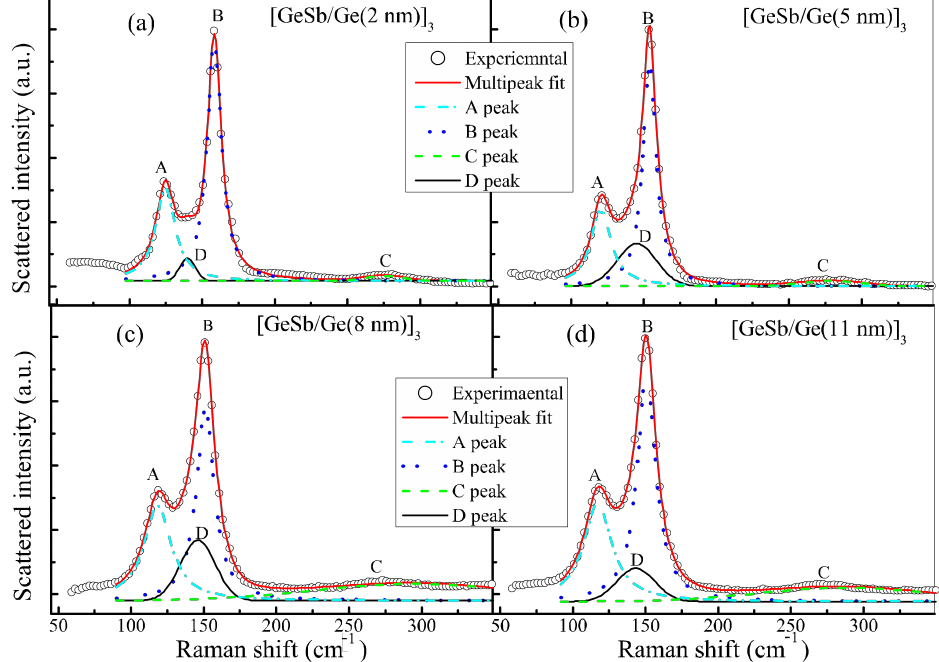
Figure 5. Raman spectra of four SLL sample [GS(15 nm)/Ge(x nm)] 3 films and their best fittings with a multi-function. ( a) x = 2, ( b ) x = 5, ( c ) x = 8, ( d ) x = 11. The letters A–D denote the individual Raman scattering spectrum of four vibration modes mentioned in the text,